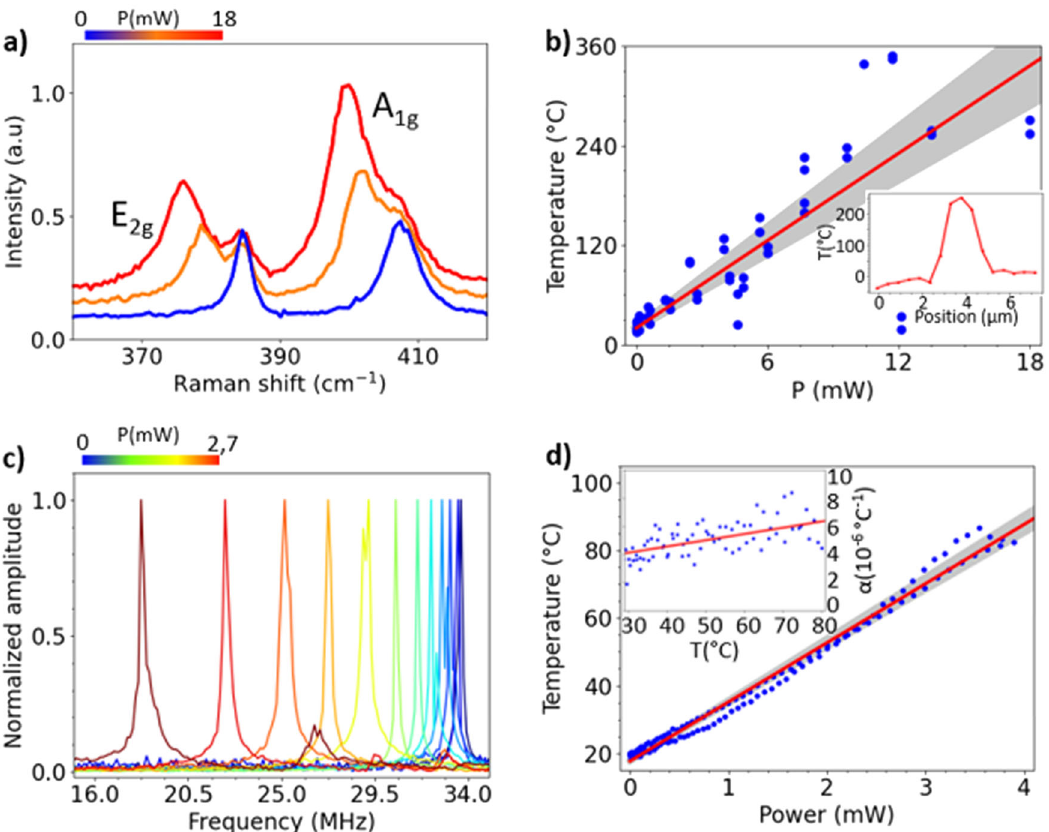
Fig. 3 Thermal transport measurement. a Raman spectroscopy of MoS 2 membrane at different joule heating power ( P ). Blue line: no bias applied, the membrane is not heated. Orange and red: we applied different source drain bias and achieved a heating power of P = 8 mW and P = 19 mW. b Temperature, obtained from Raman, of the 2D material in function of the applied power. The red line is a linear fi t of the curve and the gray area the incertitude of the slope. In inset, the spatial distribution of temperature measured by Raman during Joule Heating of 1 mW along a MoS 2 membrane center at 3.5 µm along the axe x ( c ) Resonant frequency of MoS 2 membrane at different Joule heating power ( P ) from P = 0 mW to P = 2.7 mW ( V g = 1 V). d Temperature of the membrane in function of the applied power extracted from the mechanical resonance of the membrane. In inset, the extracted thermal expansion coef fi cient α in function of the